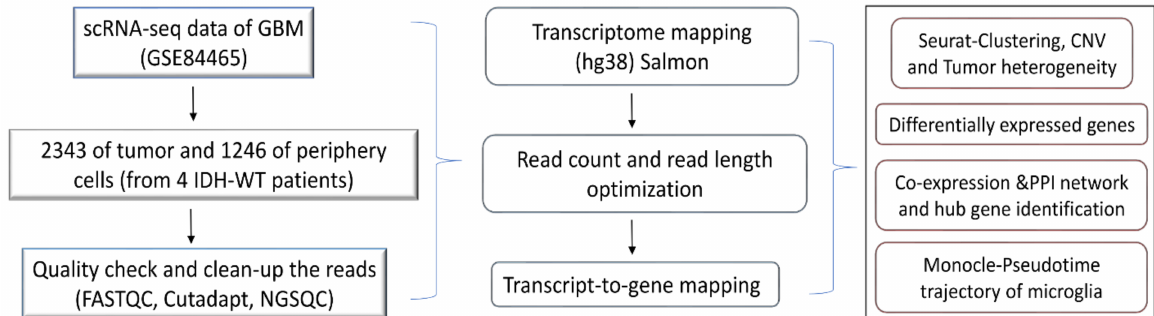
Figure 1. Schematic diagram for the study